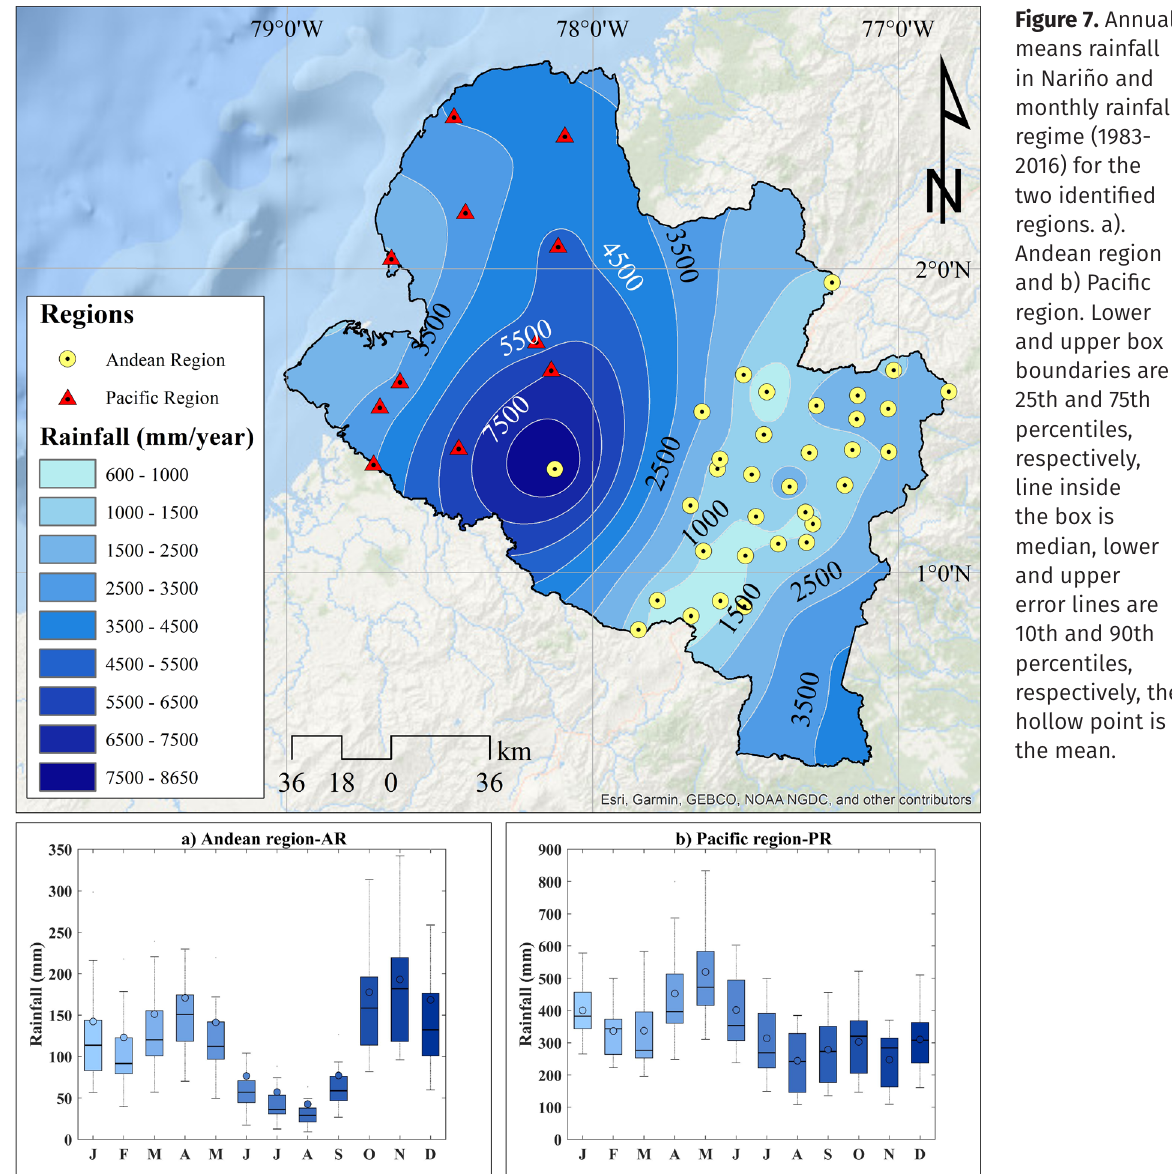
Figure 7. Annual means rainfall in Nariño and monthly rainfall regime (1983- 2016) for the two identified regions. a). Andean